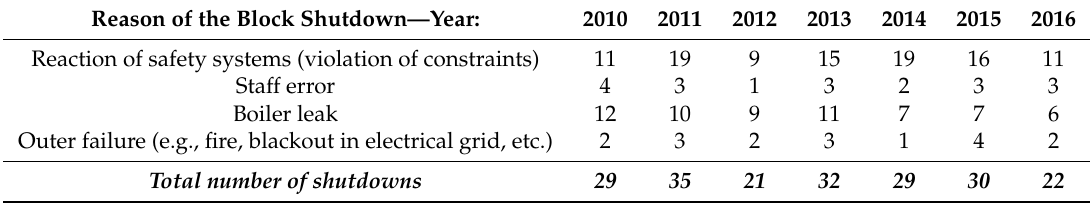
Outer failure (e.g., fire, blackout in electrical grid,